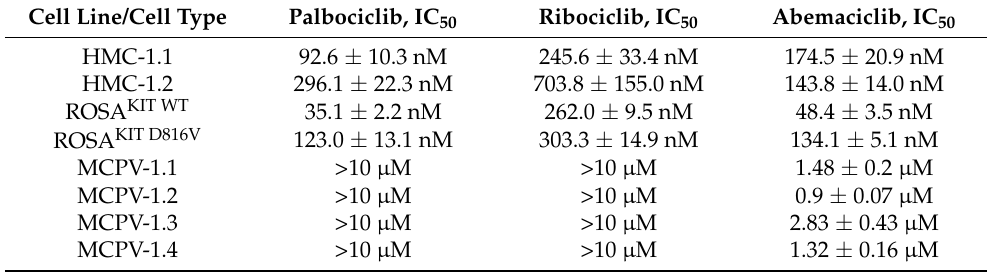
Table 2. Effects of CDK4/CDK6 inhibitors on the proliferation of various human mast cell